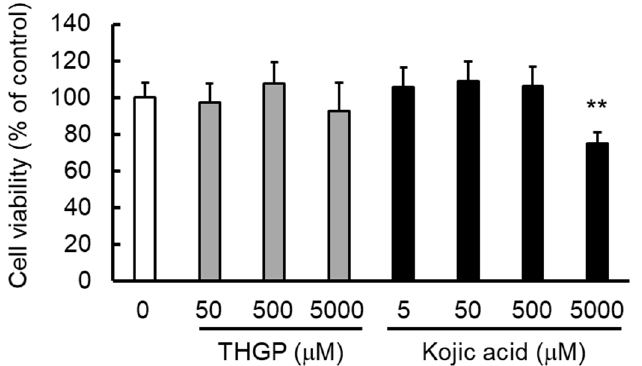
Figure 3. Cell viability after treatment with THGP or kojic acid. B16 4A5 melanoma cells were